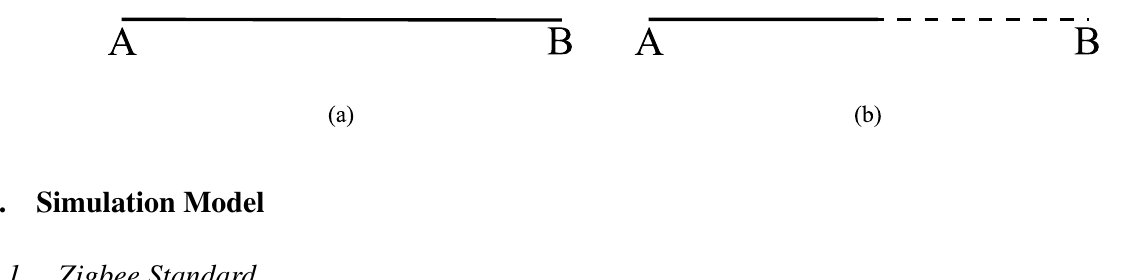
Figure 2. Graphical notation for communication links: (a) A and B communicate with each other (bidirectional communication); (b) only A can transmit to B (monodirectional